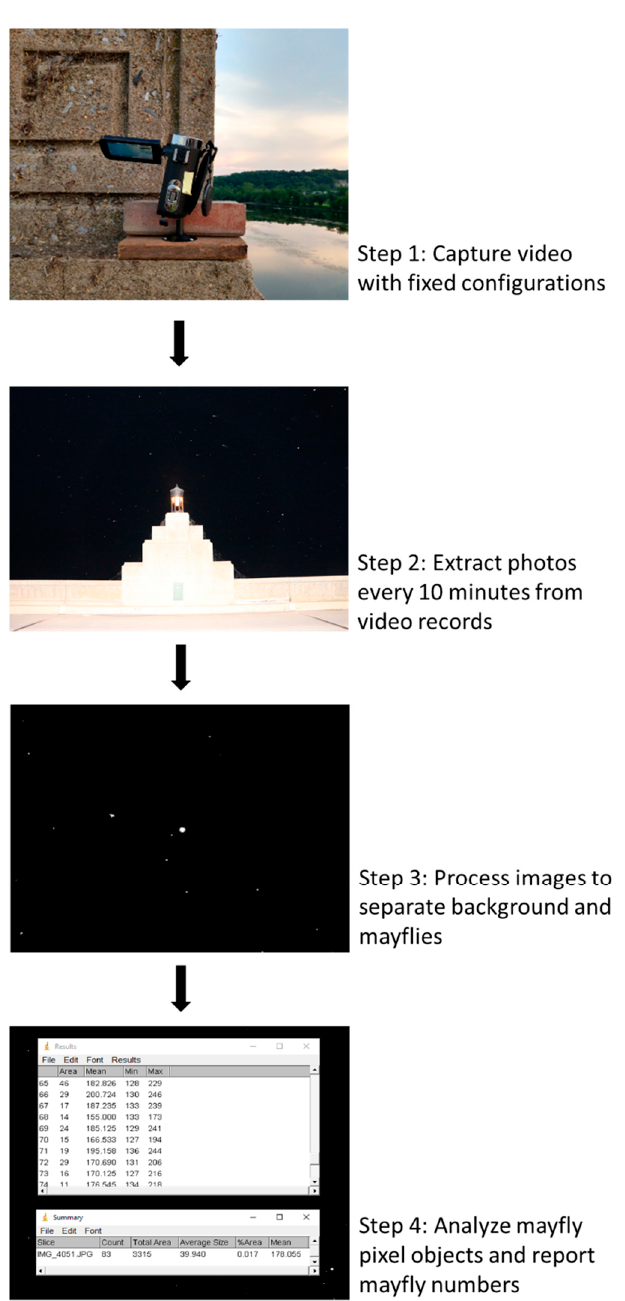
Figure 3. A step-by-step data extraction method was utilized to count the number of mayflies (white dots in steps 2 and 3) in each